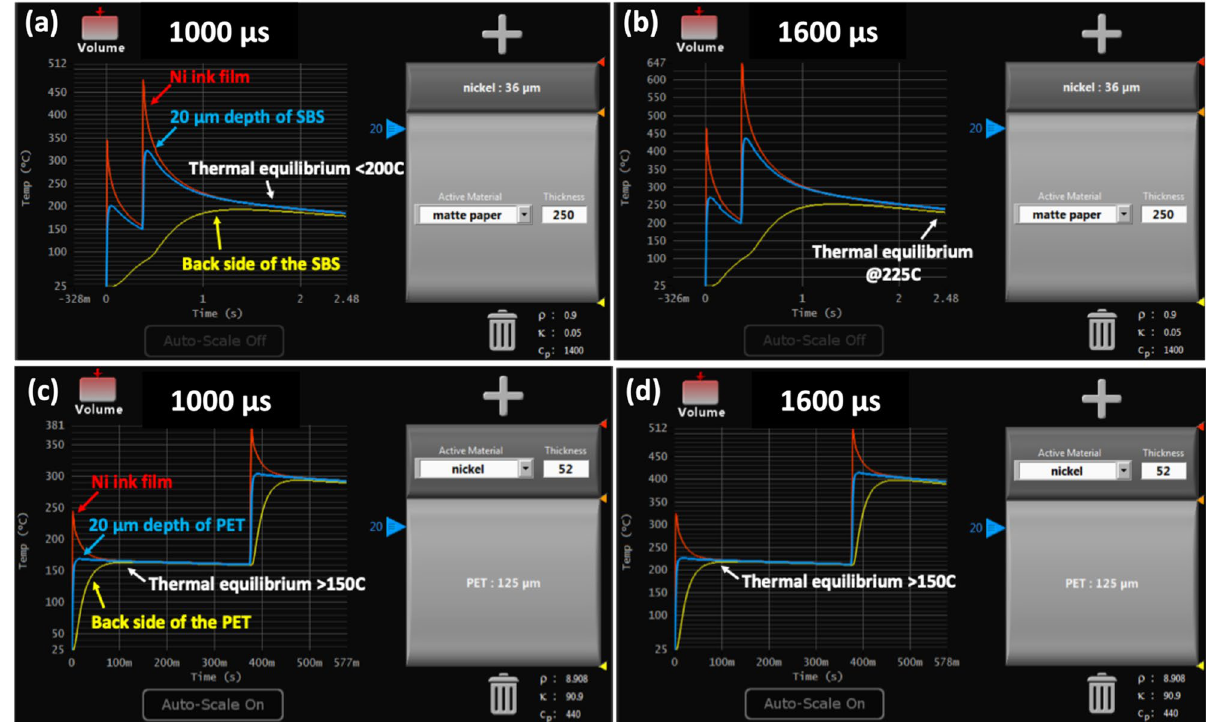
Figure 14. Simulation results by the SimPulse software: Thermal profile of Ni ink ( a ) at 1.0 ms on SBS, ( b ) at 1.6 ms on SBS, ( c ) at 1.0 ms on PET, ( d ) at 1.6 ms on